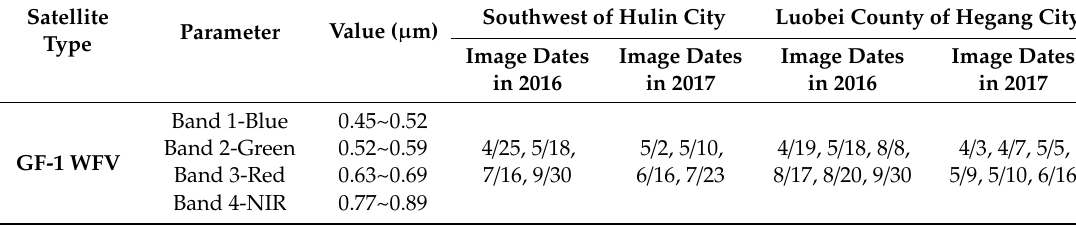
Table 1. Specifications of GF-1 wide filed view (WFV) imagery used for classifications.